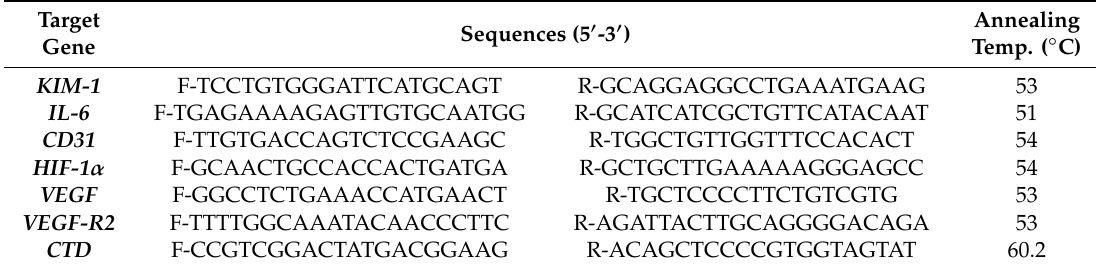
Table 1. List of oligonucleotides used to evaluate KIM-1, IL-6, CD31, HIF-1 α , VEGF, VEGF-R2 and CTD gene